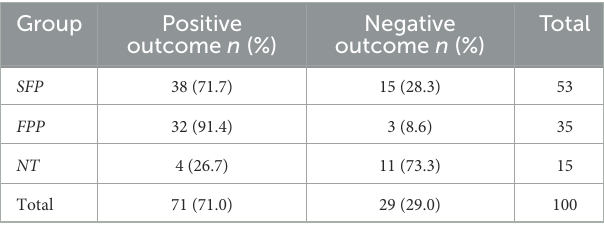
TABLE 2 Contingency table with the three groups of patients and treatment outcome.